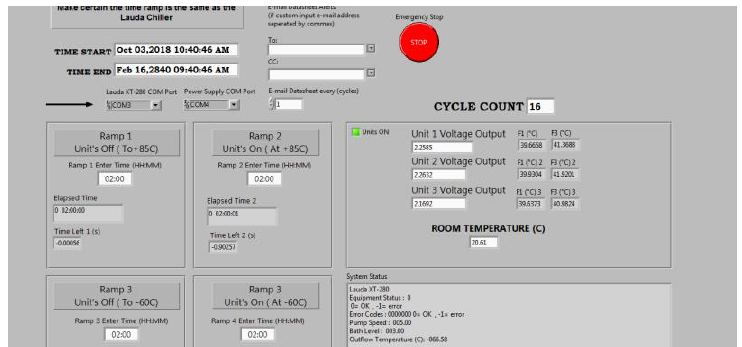
Figure 9. Thermal Shock Life Stand User Screen.